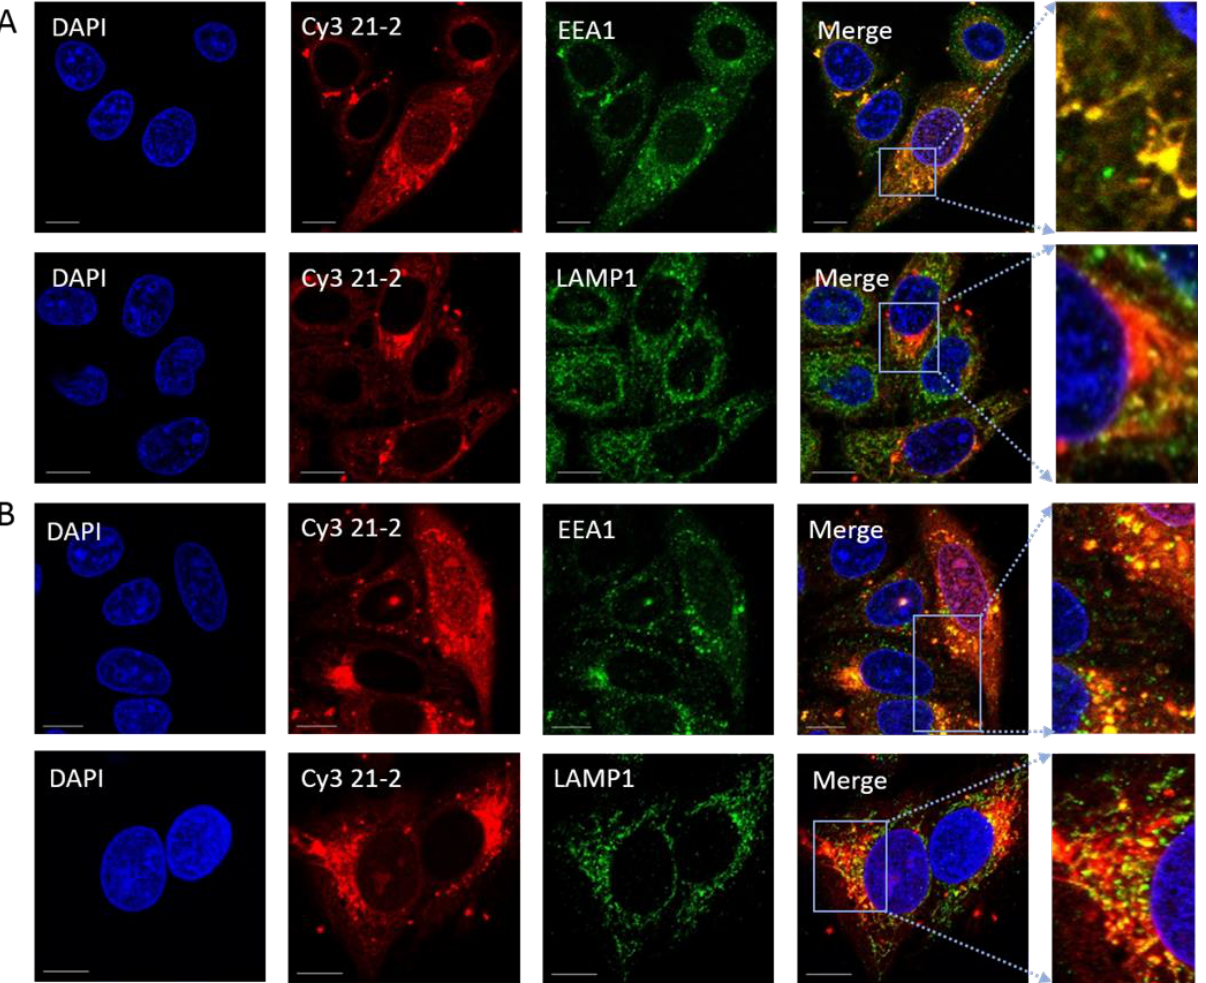
Figure 4. Cont Figure 4. Cont.